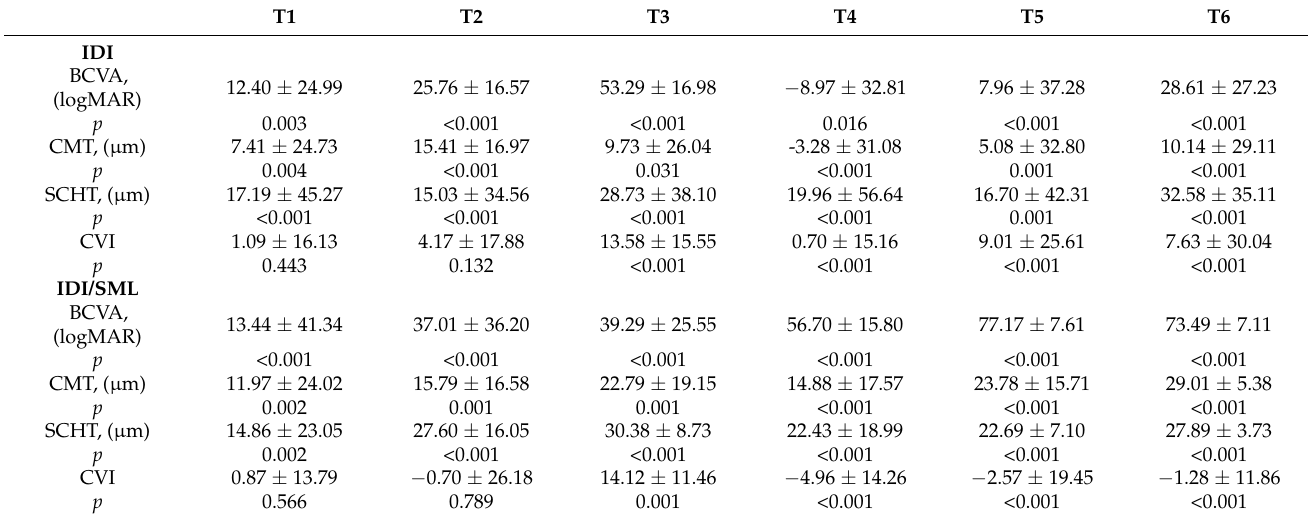
Table 2. Mean and standard deviation of the percentage variation from baseline for each anatomical and functional parameter. The p -values indicate the results for the paired sample t -test for each time point versus